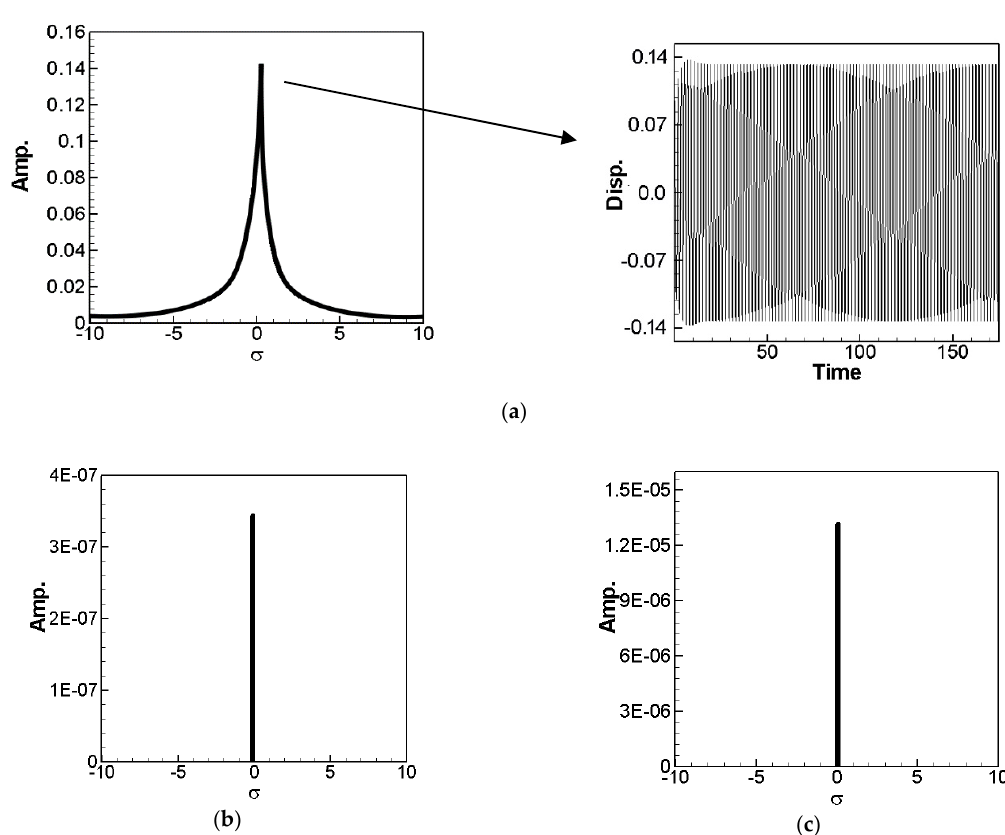
Figure 12. Fixed point plots when exciting the 1st mode,( a ) 1st mode Fixed point plot and time response,( b ) 2nd mode Fixed point plot,( c ) 3rd mode Fixed point plot .